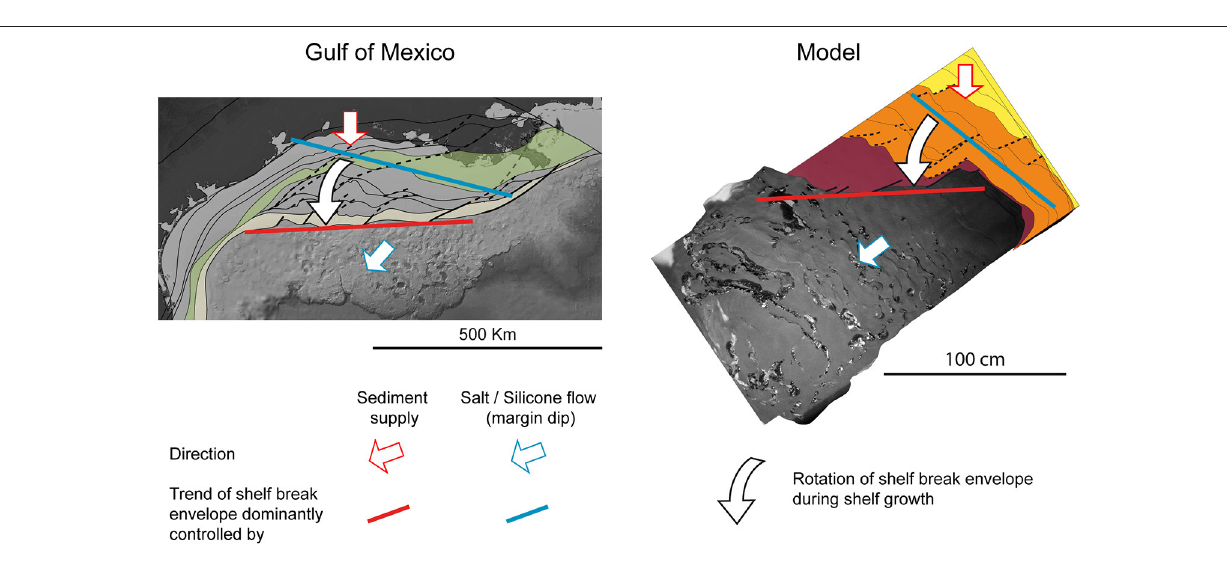
FIGURE 10 | Counterclockwise rotation of the shelf envelope in the Gulf of Mexico and in the model. The rotation results from the interaction between salt flow whose rate reduces with time and sediment supply whose rate is either constant (model) or increasing with time (Gulf of Mexico). Whereas, the role of salt flow decreases with time, transfer zones remain parallel to salt